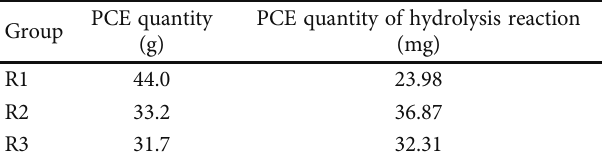
Table 3: Characteristics of